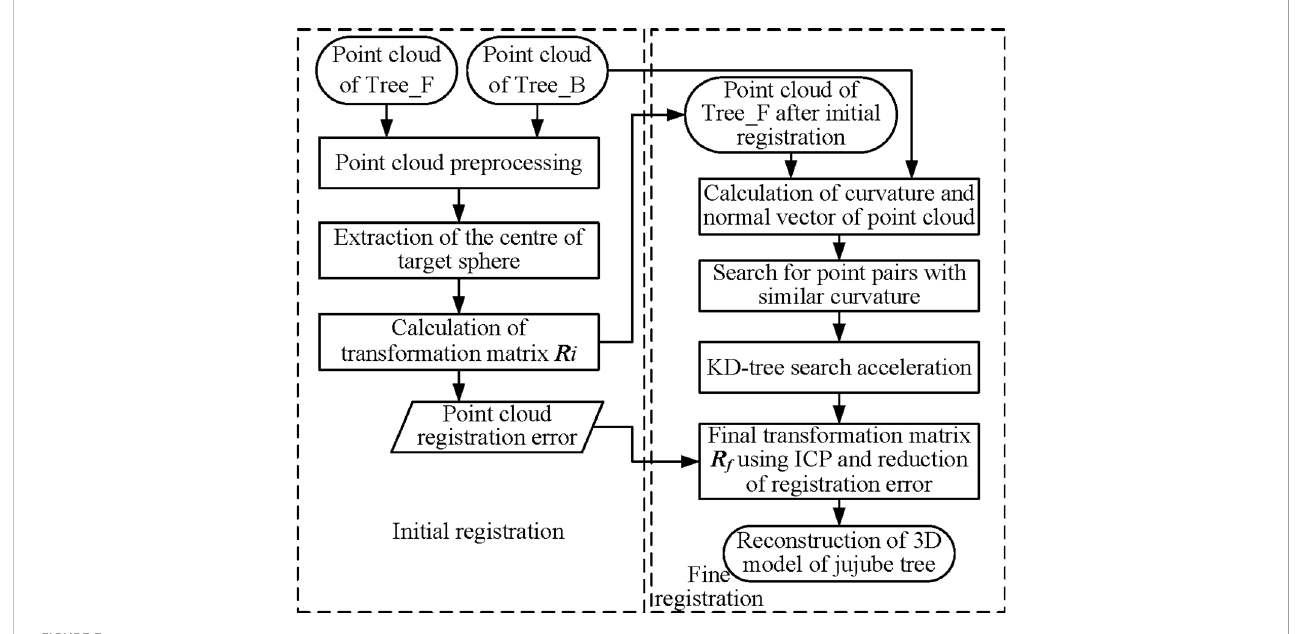
FIGURE 3 The overall reconstruction